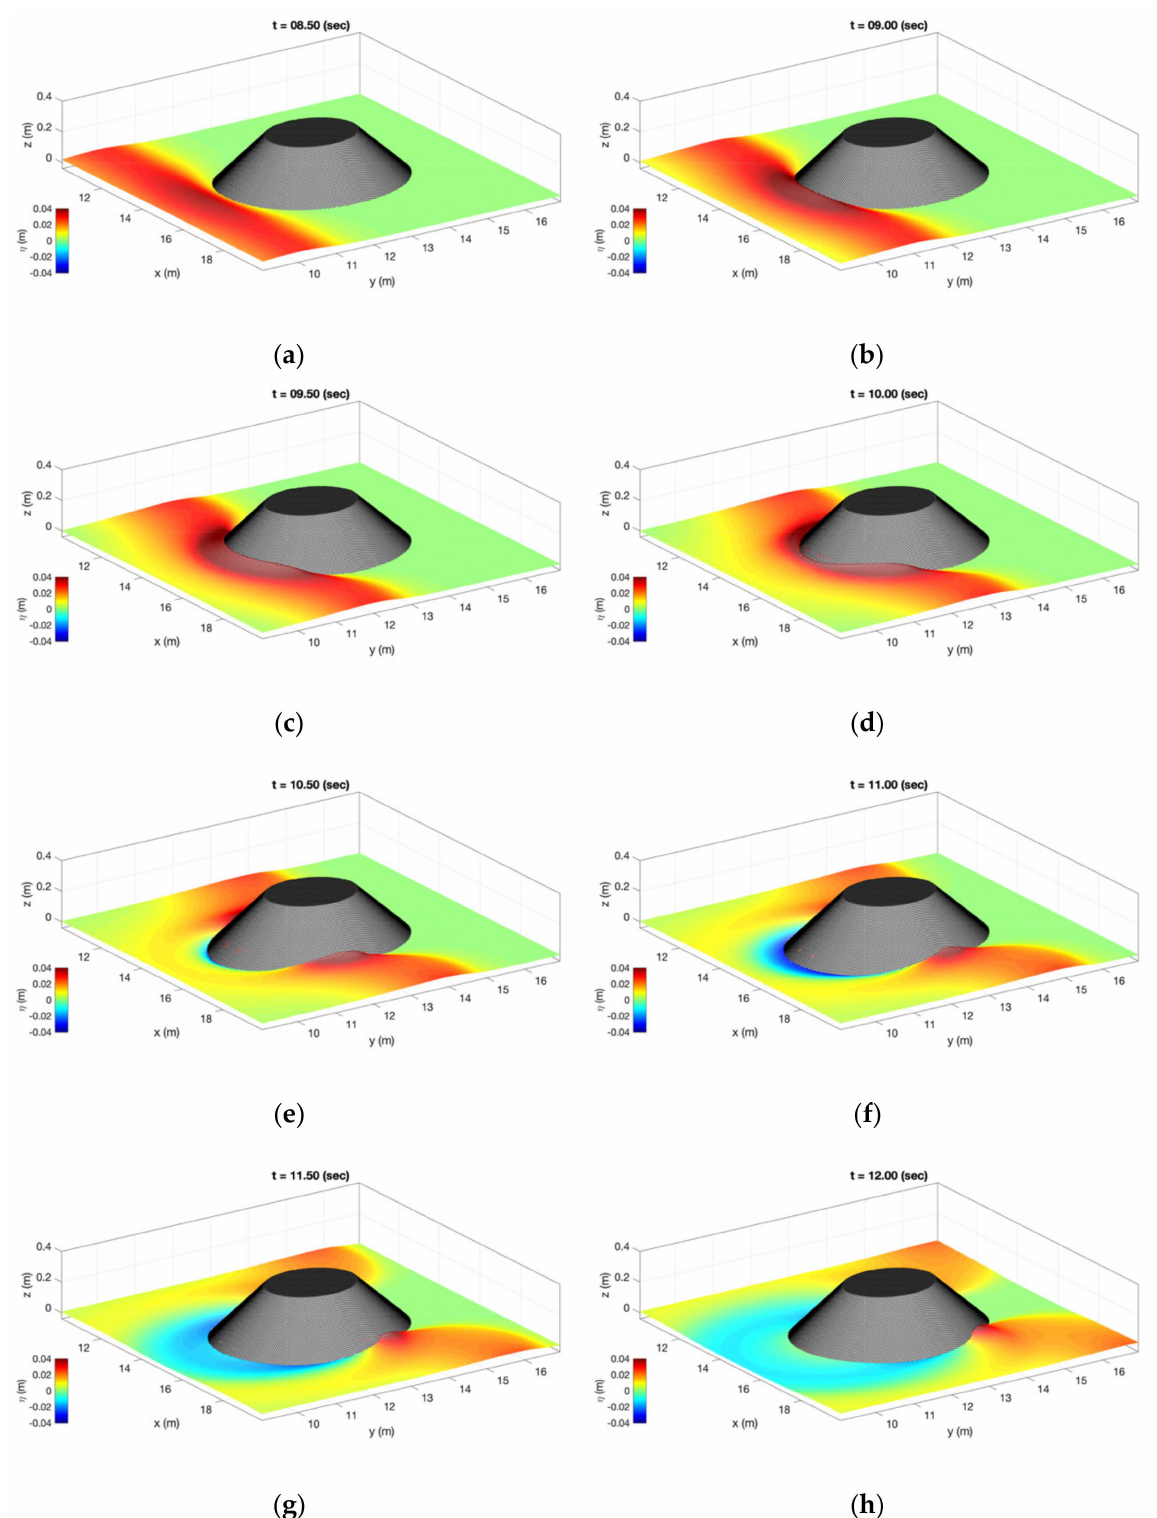
Figure 5. Snapshots for the computed free surface elevations of Grid 02 on the frontal side of the circular island (A/h = 0.091) at t = ( a ) 8.5, ( b ) 9.0, ( c ) 9.5, ( d ) 10.0, ( e ) 10.5, ( f ) 11.0, ( g ) 11.5, and ( h ) 12.0 sec. The incident solitary wave propagates along the + y -direction. The color bar indicates the free surface elevations in the unit of m. The gray-shaded object shows the circular